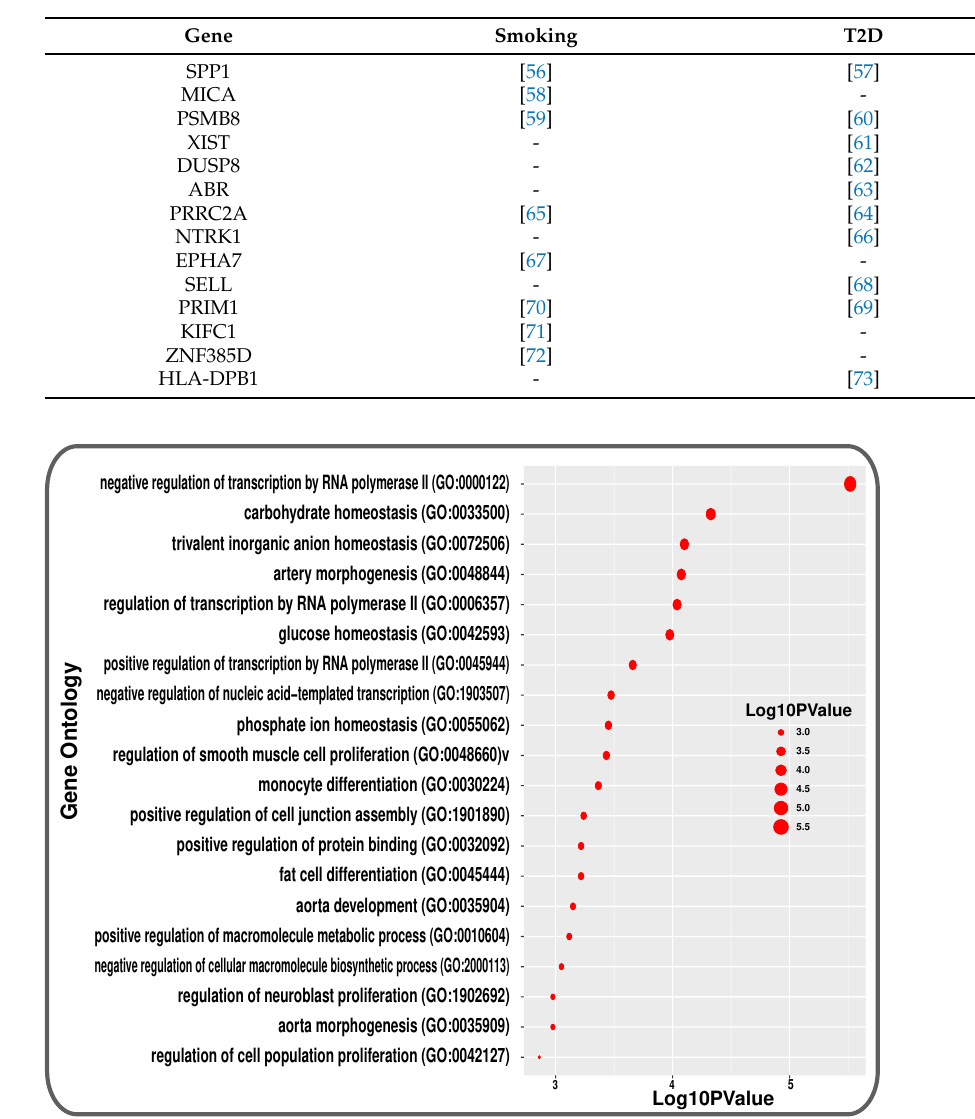
Figure 12. Top 20 GOs are represented using a bubble plot that are associated with both conditions in GWAS